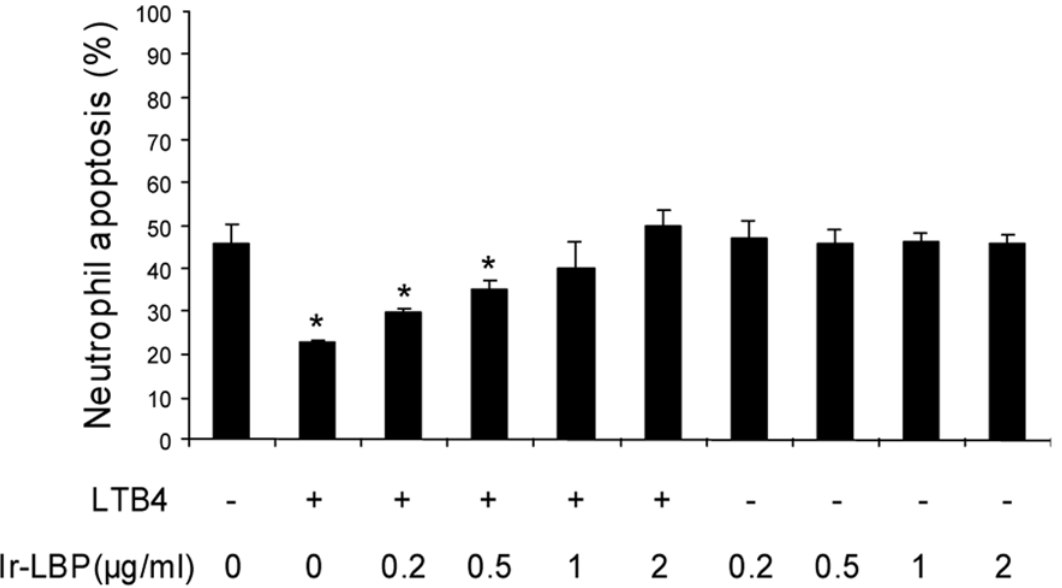
Figure 6. Ir-LBP effect on transendothelial migration of freshly isolated neutrophils stimulated by LTB4. Results represent the number of cells that cross the endothelial barrier after 2 h. Results were obtained from two independent experiments and are expressed as a fold increase over control. One LTB4 concentration and four Ir-LBP concentrations, 10E 2 7 M and a range from 0.2 m g/ml to 5 m g/ml respectively were used.